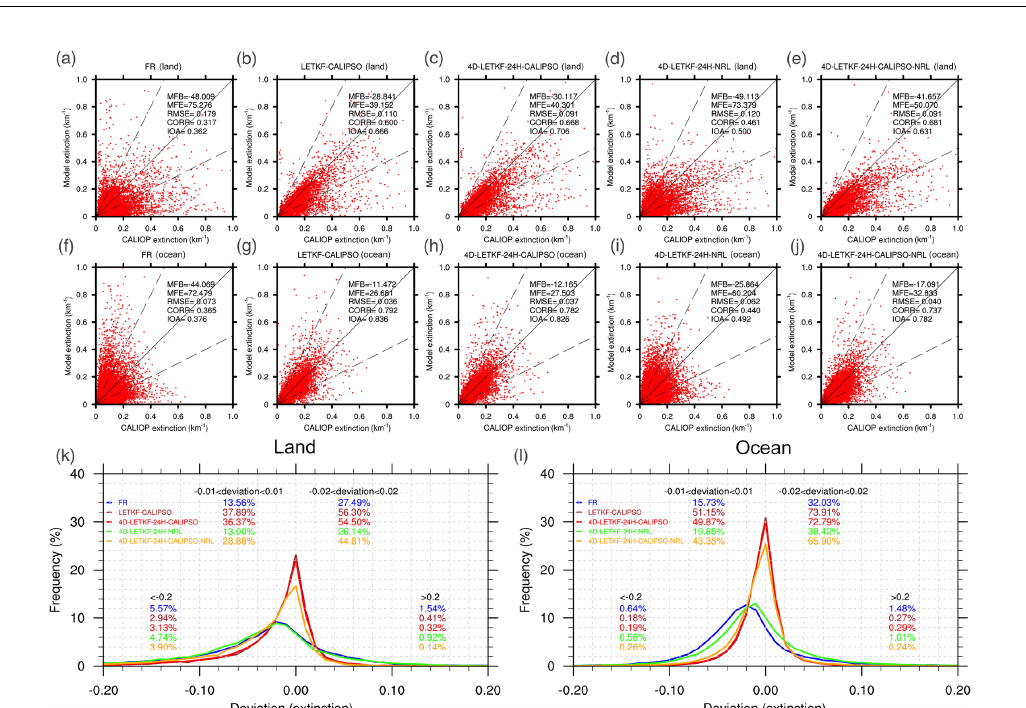
Figure 2. Scatter plots of the CALIOP (Cloud-Aerosol Lidar with Orthogonal Polarization) hourly aerosol extinction coefficients at 532nm (km − 1 ) versus the simulated ones at 550nm over the global land (a, b, c, d, e) and ocean (f, g, h, i, j) during November 2016 for the FR, LETKF-CALIPSO, 4D-LETKF-24H-CALIPSO, 4D-LETKF-24H-NRL, and 4D-LETKF-24H-CALIPSO-NRL experiments. The solid black line is the 1 : 1 line and the dashed black lines correspond to the 1 : 2 and 2 : 1 lines. MFB, MFE, RMSE, CORR, and IOA represent the mean fractional bias, the mean fractional error, the root mean square error, the correlation coefficient, and the index of agreement, respectively. Frequency distributions of deviations (modeled extinction coefficients minus the CALIOP-observed ones) over the global land (k) and ocean (l) . The percentages of deviations between ± 0 . 01, ± 0 . 02, < − 0 . 2, and > 0 . 2 are also